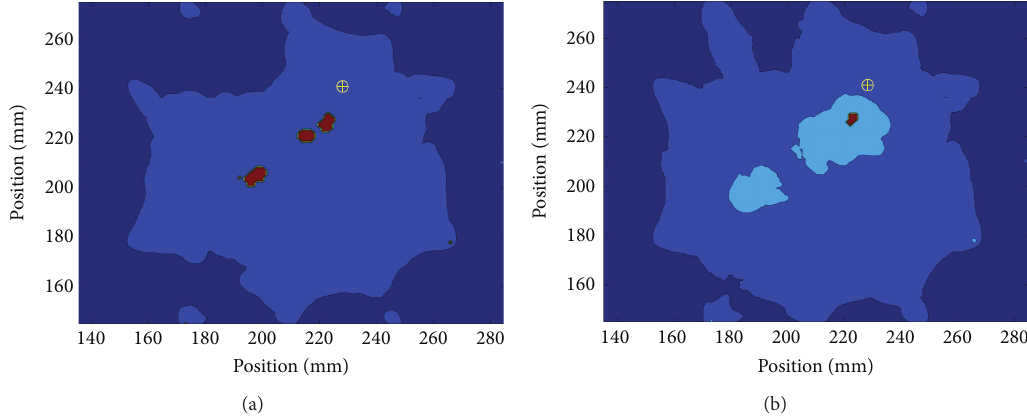
Figure 5: (a) Power amplitude results with no damage progression factor (left) and (b) power amplitude results with damage progression factor of 1.10 (right) ∗ damage location indicated by yellow